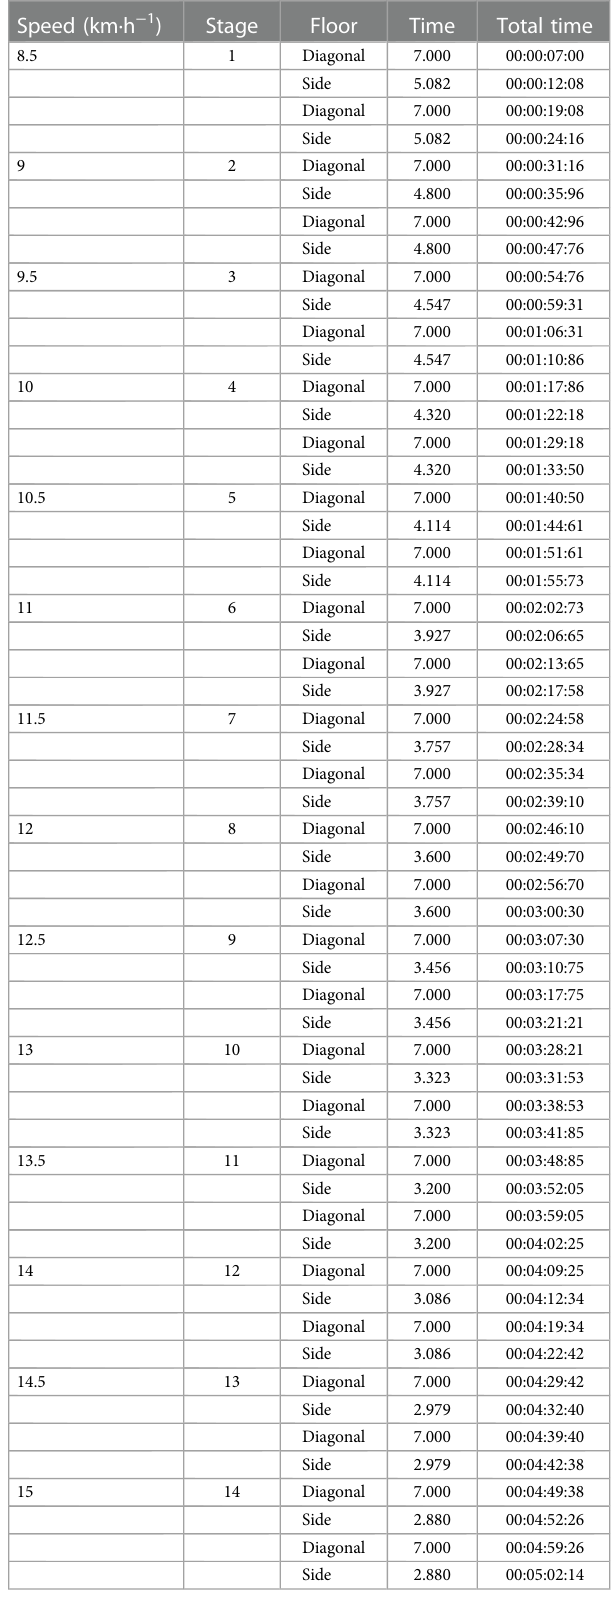
TABLE 1 Details of the artistic gymnastics-speci fi c endurance test. Speed (km·h − 1